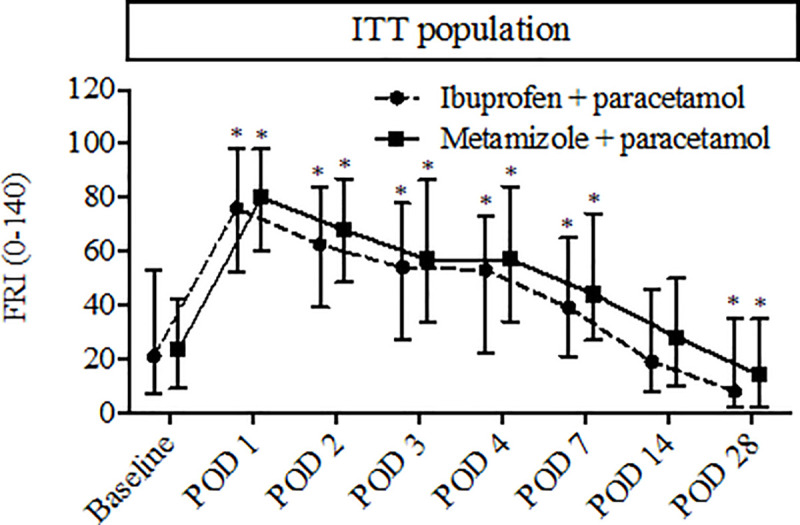
Quality of Recovery (QOR) at baseline and during follow-up.Total functional recovery index (FRI) scores are presented as median (25th - 75th percentile) for the “intention to treat” population. No significant differences were found between pain treatment groups based on the Mann-Whitney U test. QOR at follow-up was also compared to baseline (based on a Wilcoxon signed-rank test and Bonferroni adjustment). Significant differences from baseline are presented with an asterisk (*).